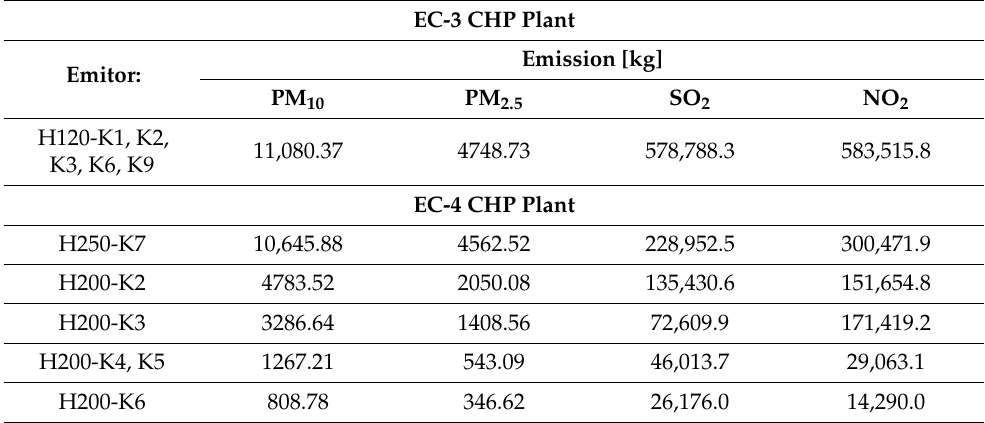
Table 2. Emission of pollutants from EC-3 and EC-4 in 2019 (own calculations based on data from Veolia Energia Ł ó d´z).